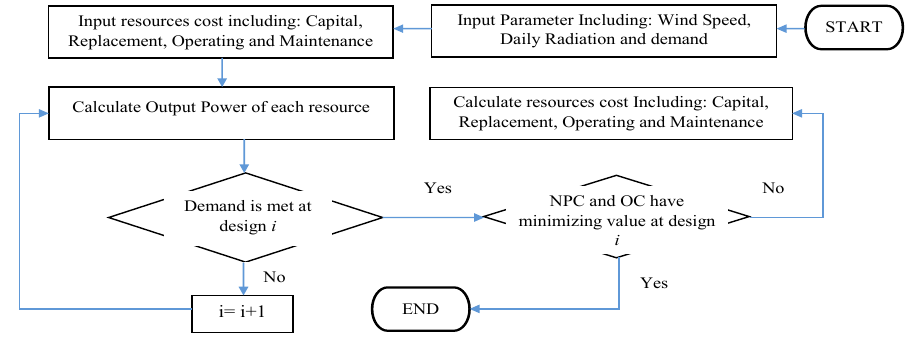
Fig. 2. Optimization